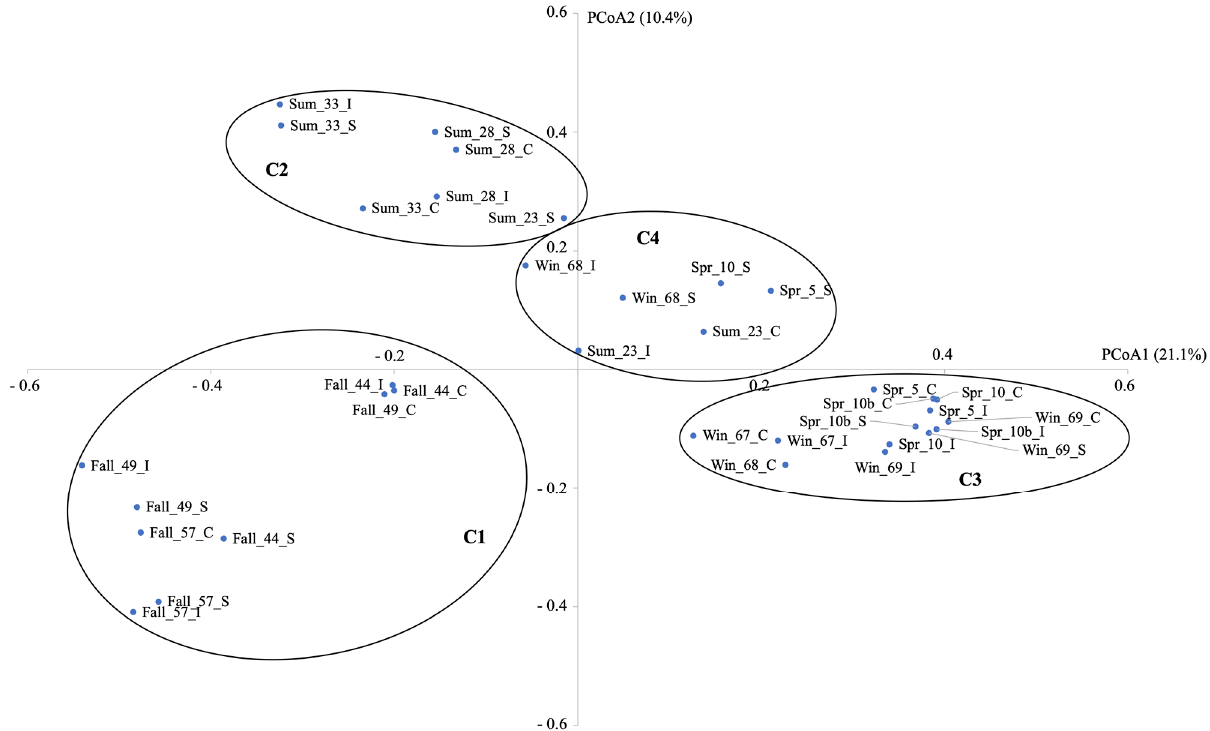
Figure 2. Principal coordinate analysis (PCoA) based on a Bray–Curtis distance matrix between bacterial gut microbiome communities. S, stomach; C, cecum; I, intestine; Spr, spring; Sum, summer; Win, winter. Table 1. Permutational multivariate analyses (PERMANOVA) testing variation in bacterial commu- nity composition explained by season (fall, winter, spring, and summer), gut microbiome section (stomach, cecum and intestine), fish sex (male or female), and fish